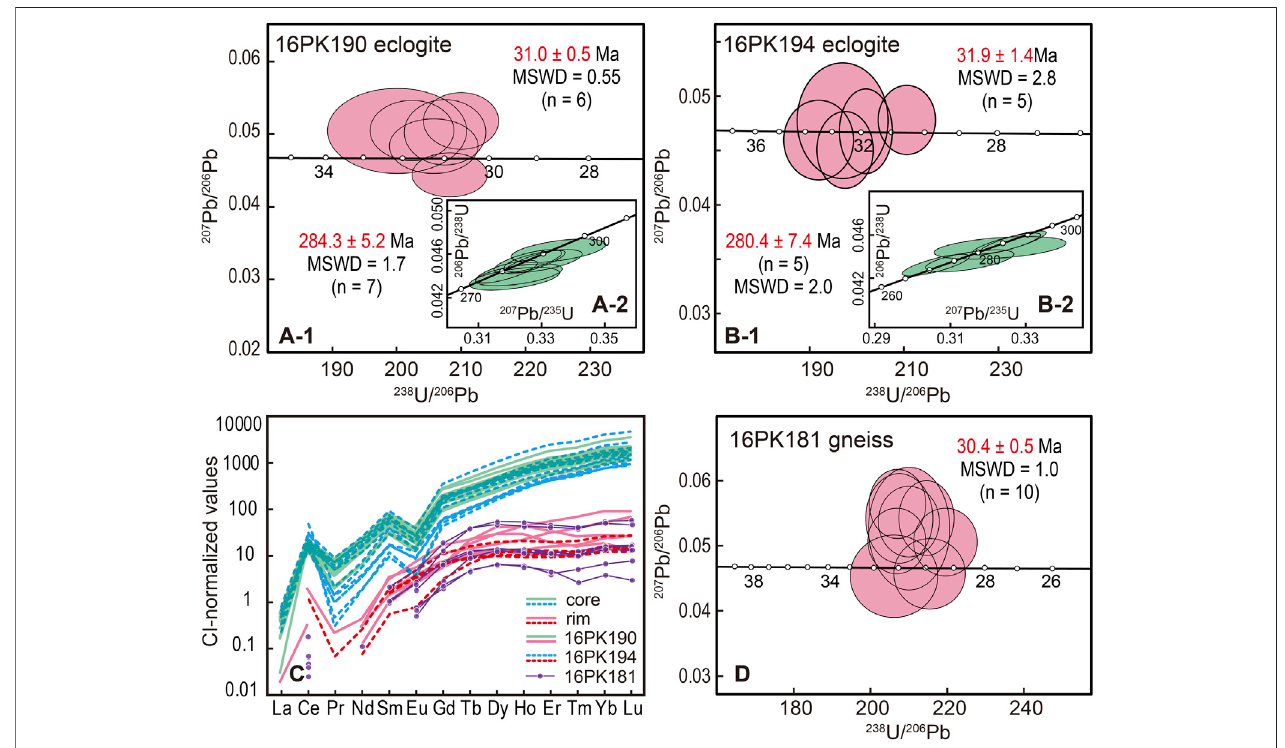
FIGURE 6 | Zircon U-Pb dates (A,B,D) and REE patterns (C) . (A-1) , (B-1) , (D) Tera-Wasserburg diagrams of metamorphic zircon U-Pb data uncorrected for common Pb. (A-2) , (B-2) Concordia diagrams for zircon cores of the Stak eclogites. (C) Chondrite-normalized REE patterns of zircons in the Stak samples. Chondrite data are from McDonough and Sun (1995). n, number of analyses; MSWD, mean square of weighted deviates.